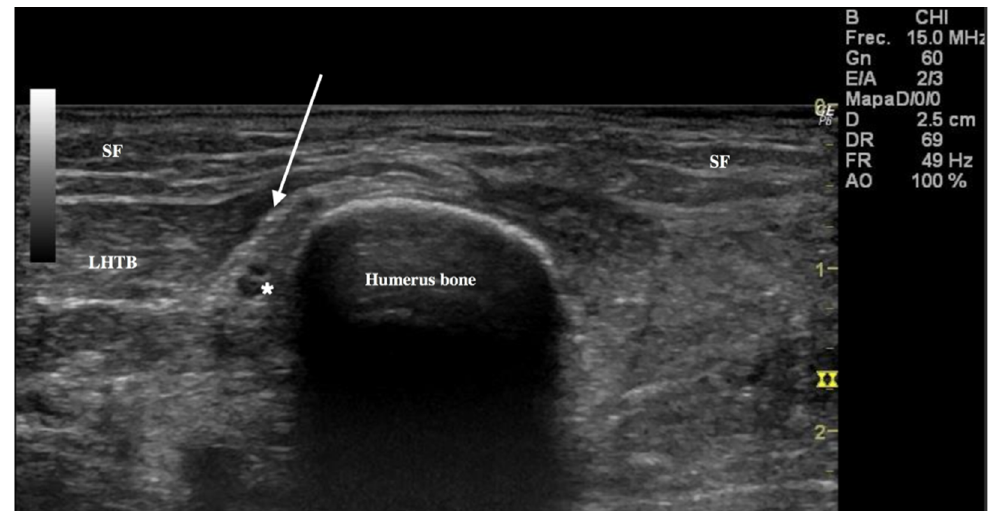
Figure 2. Ultrasound of the aponeurotic part of lateral head triceps brachii (LHTB) (white arrow) that forms a fibrotic tunnel for the radial nerve (RN) (*) and posterior antebrachial cutaneous nerve before the RN crosses the lateral intermuscular septum, followed by the superficial fascia or subcutaneous fatty layer (SF).